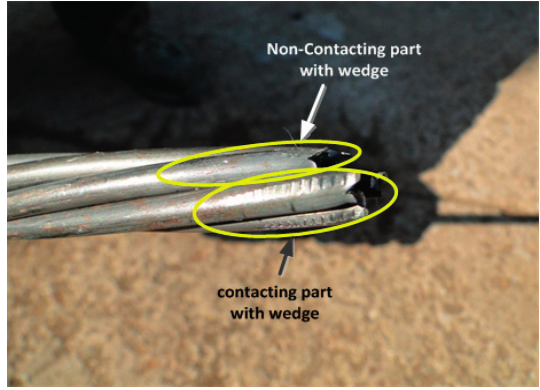
Figure 11. Strand-wedge